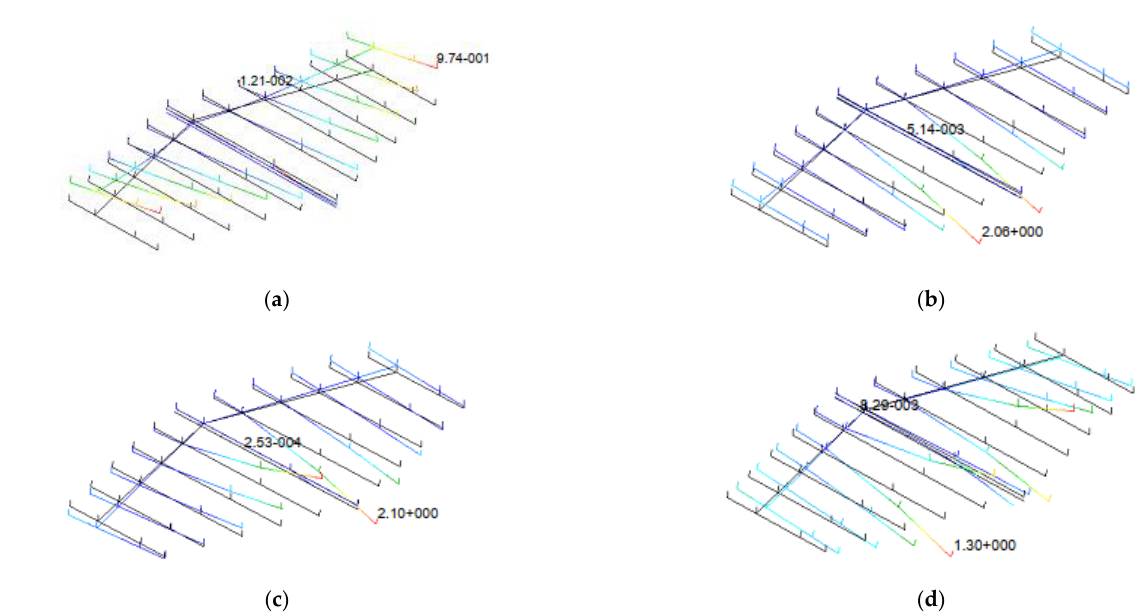
Figure 5. Wing component modal shape of first four elastic modes. ( a ) 1st vertical bending. ( b ) 2nd vertical bending. ( c ) 1st horizontal bending. ( d ) 1st torsion.